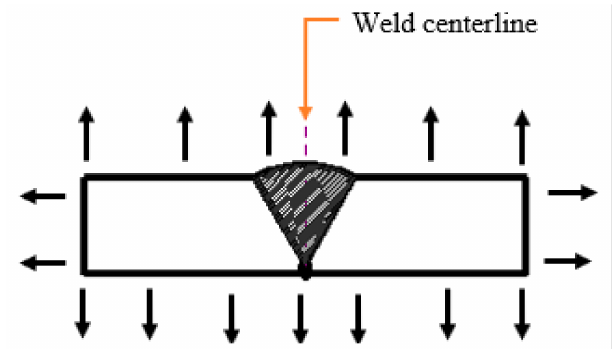
Figure 5. Radiation and convection heat losses in